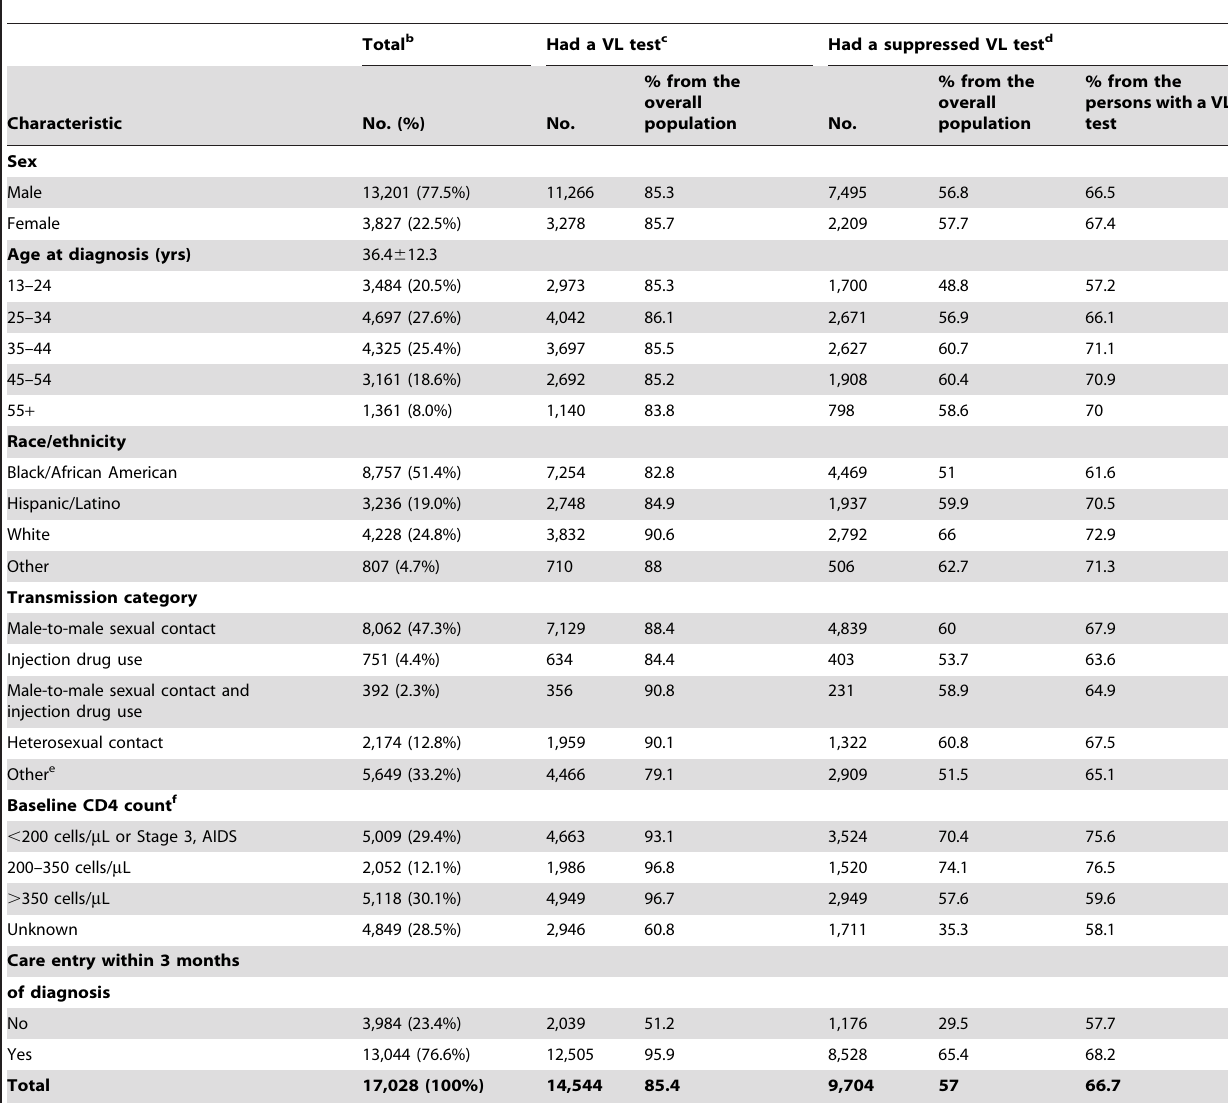
Table 1. Characteristics of adolescents and adults a diagnosed with HIV infection, 2009, 19 U.S.